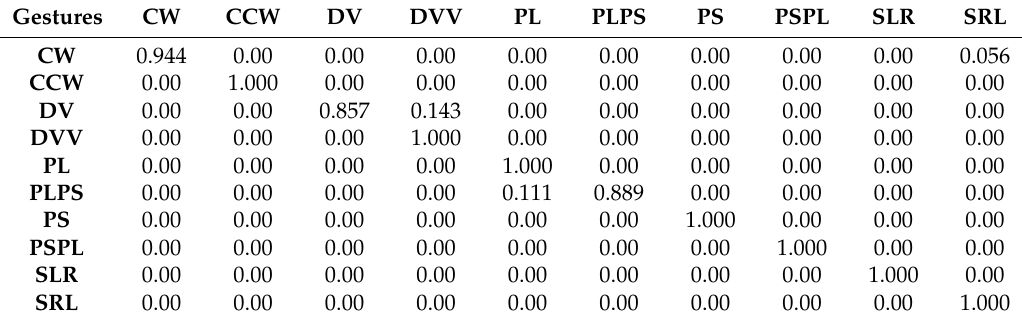
Table 2. Confusion matrix of 10 types of hand gesture.